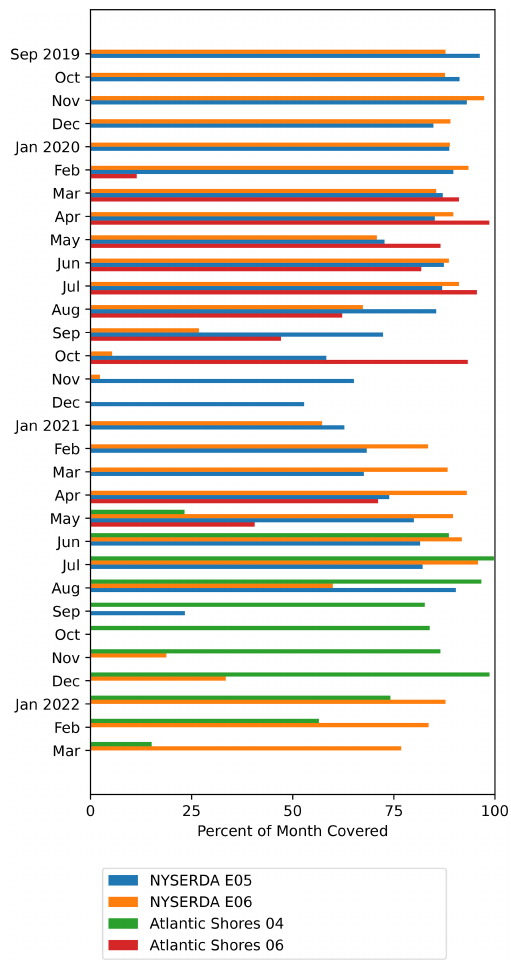
Figure 2. Data availability chart for the four lidar data sets. We kept only hourly time stamps for which we could calculate hourly average values for all the variables considered in this analysis, as detailed in the text.